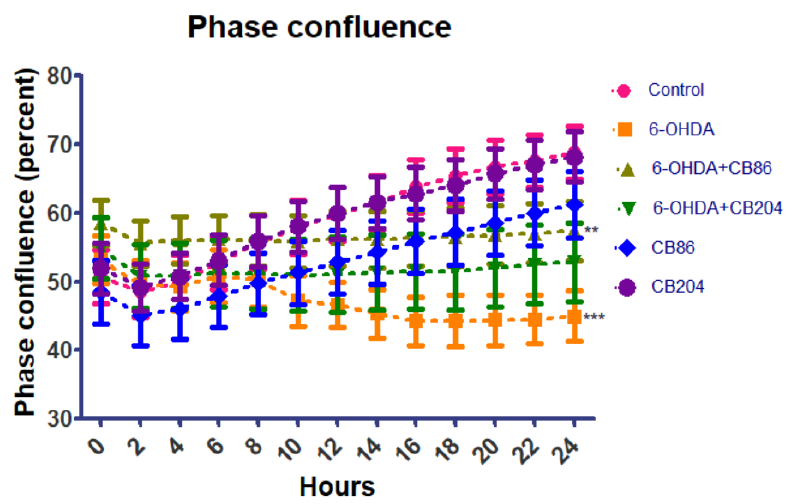
Figure 1. Phase confluence analysis: Phase confluence analysis was performed using Incucyte Zoom microscope in the different groups at 2 h intervals for 24 h. Results are expressed by mean ± SEM ( n = 4 replicates in each group). ANOVA followed by Bonferroni’s post -hoc test was performed, *** compared to control and ** compared to 6-OHDA group, p < 0.001 for both.